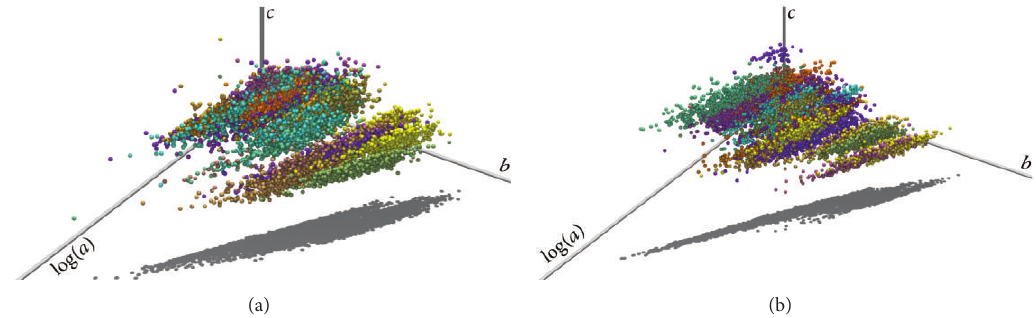
Figure 12: (a) Locus (𝑎,𝑏, 𝑐) of genes 1–20 for 40 genes (1803 2-tuple HSRFs) in Dataset 1—HRF PL regression + Canberra distance. (b) Locus (𝑎,𝑏, 𝑐) genes 21–40 for 40 genes (1803 2-tuple HSRFs) in Dataset 1—HRF PL regression + Canberra